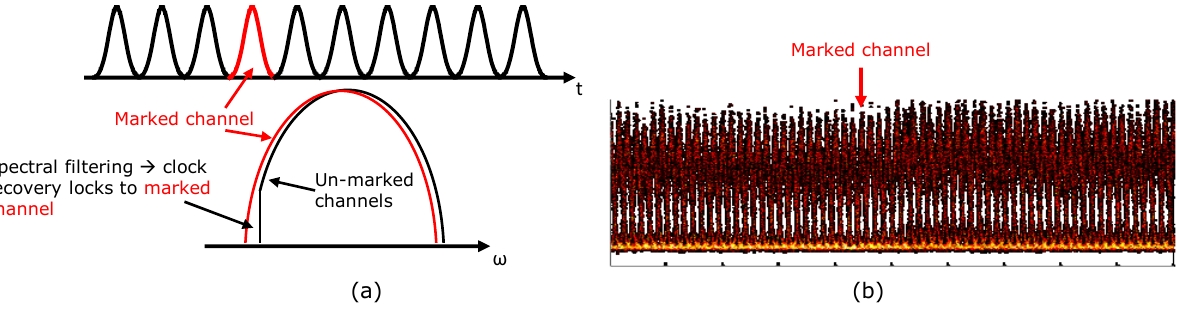
Figure 2. ( a ) Principle of channel labeling by spectral shaping; ( b ) 650 Gbit/s data signal after 80 km transmission with marked channel